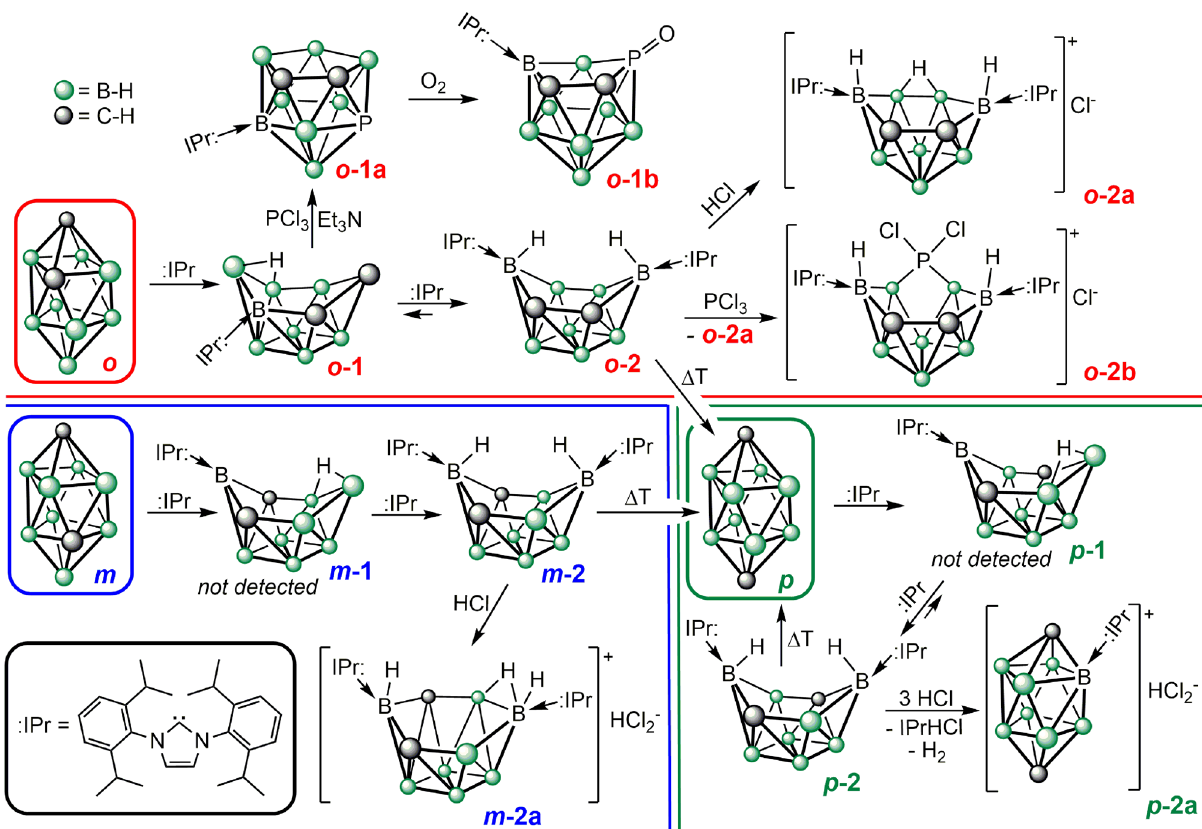
Fig. 1 Reactivity of 10-vertex closo-dicarbadecaboranes. All the ten-vertex carboranes show different reactivity towards the carbene and subsequently hydrogen chloride or phosphorus trichloride. closo -1,2-dicarbadecaborane is referred to as ortho ( o , red trace); closo -1,6-dicarbadecaborane is referred to as meta ( m , blue race), closo -1,10-dicarbadecaborane is referred to as para ( p , green trace). .